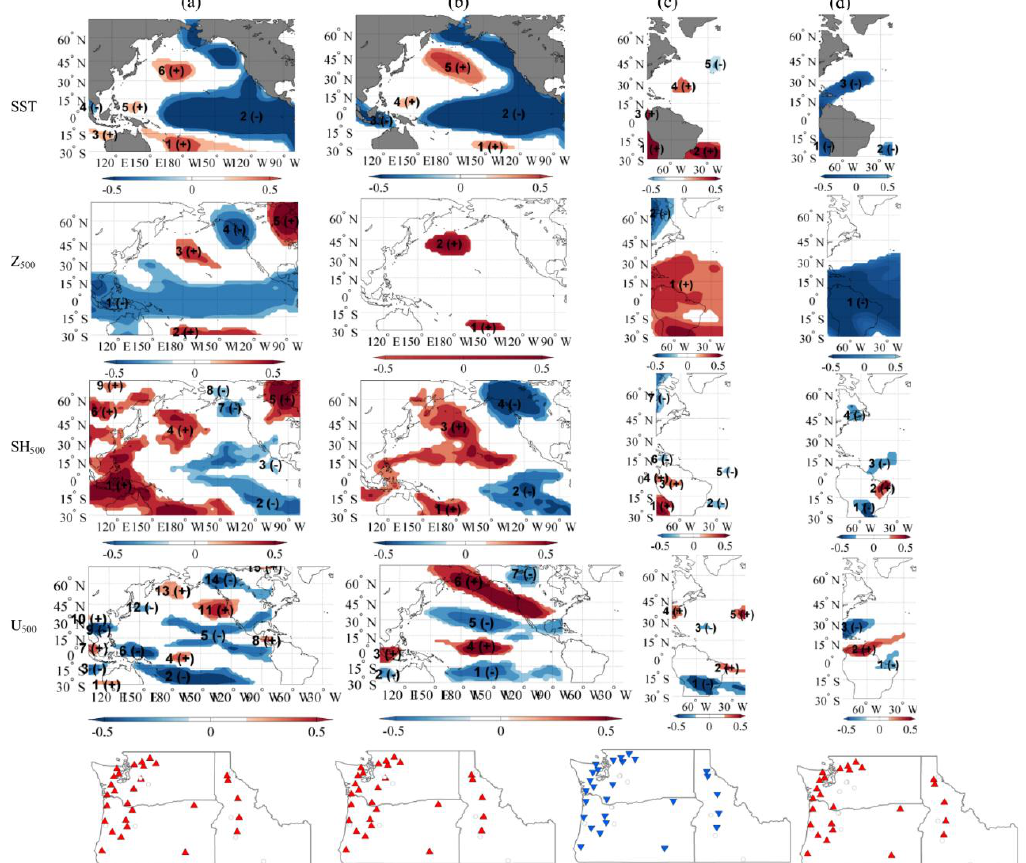
Figure 5. Heterogeneous correlation map developed for ( a ) Pacific September–November, ( b ) Pacific December–February, ( c ) Atlantic September–November, ( d ) Atlantic December–February SST, Z 500 , SH 500 , and U 500 with Northwest April–August streamflow. Significant regions with positive (negative) correlations are represented by red (blue). Significant streamflow stations are represented by red upward (blue downward) triangles.